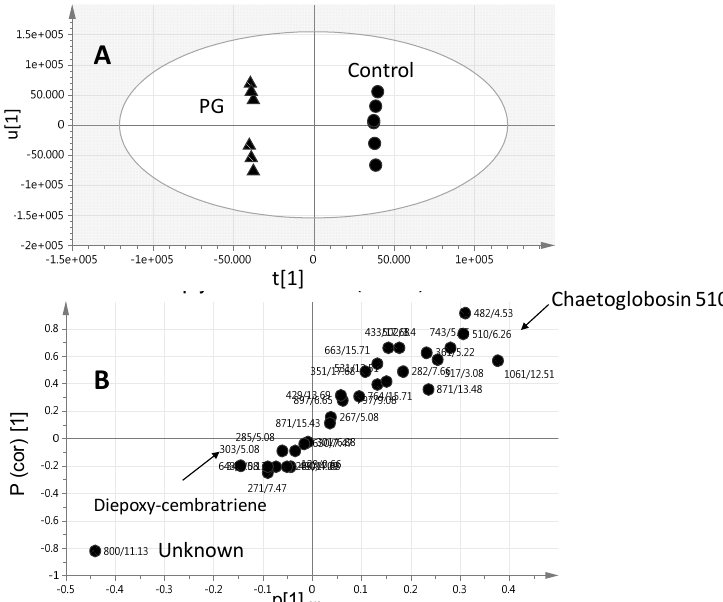
Figure 6. OPLS-DA score plot ( A ) derived from modelling Lobophyton pauciflorum corals elicited with PG at a dose of 20 and 200 μ M modelled versus control unelicited corals. The S-plots from PG ( B ) show the covariance p[1] against the correlation p(cor)[1] of the variables of the discriminating component of the OPLS-DA model. Cutoff values of p < 0.05 were used; selected variables are highlighted in the S-plot with m/z and retention time in minutes and identifications are discussed in the text.